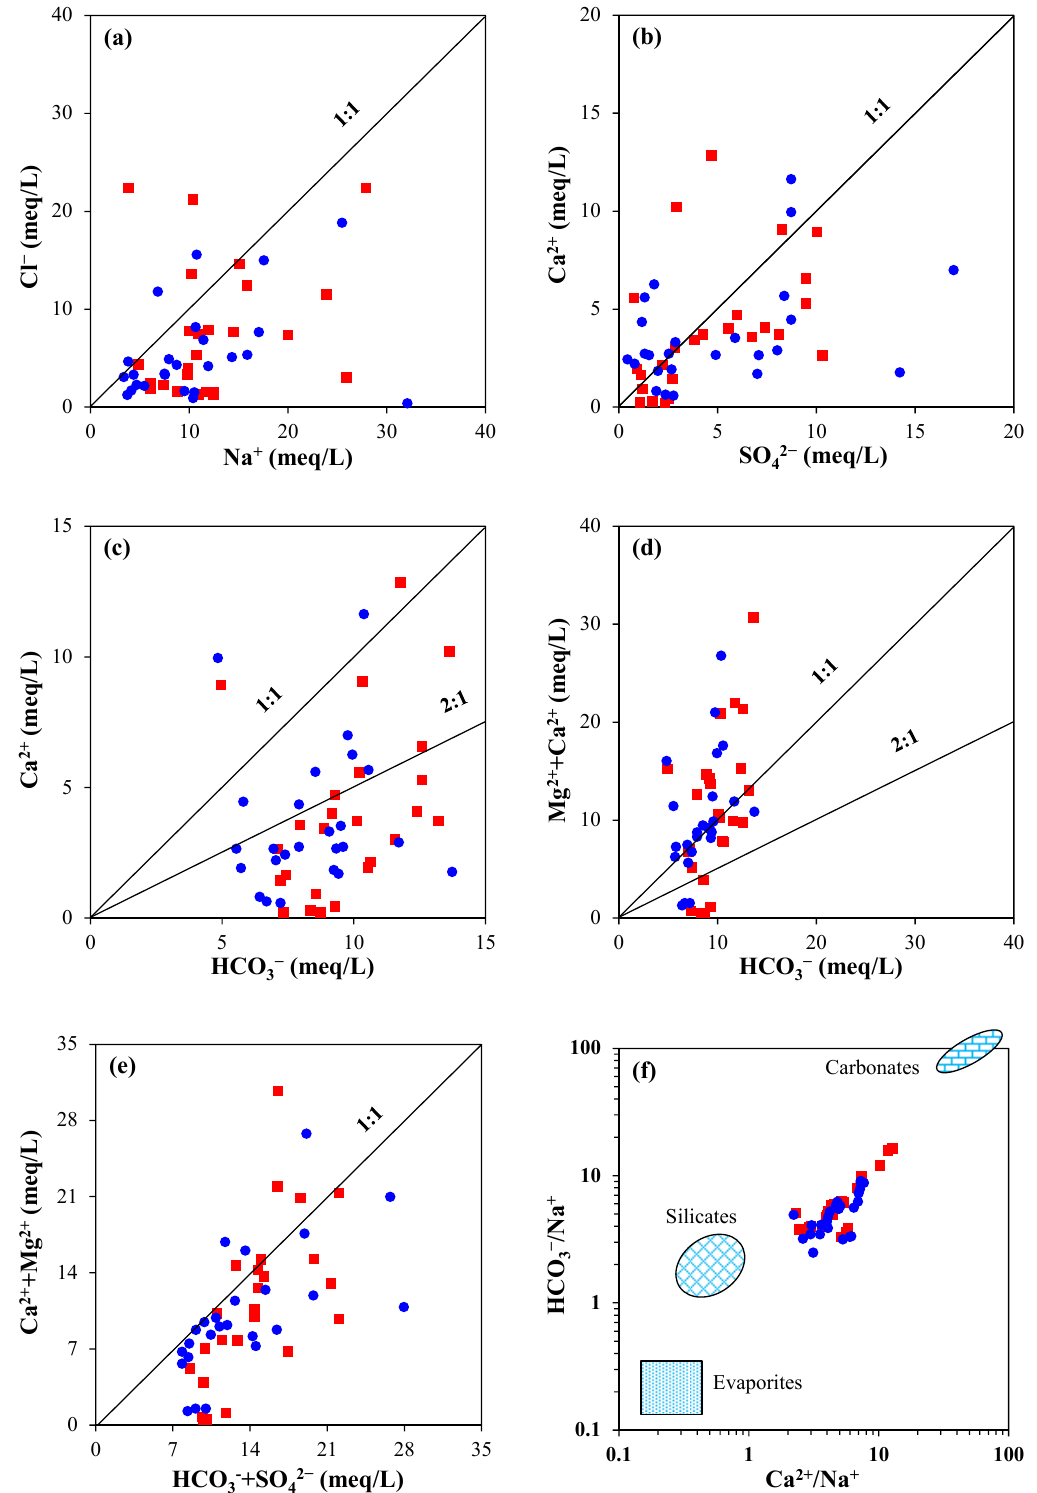
Figure 7. Plots showing ( a ) Na + versus Cl − , ( b ) SO 42 − versus Ca 2+ , ( c ) HCO 3 − versus Ca 2+ , ( d ) HCO 3 − versus Ca 2+ + Mg 2+ , ( e ) (SO 42 − + HCO 3- ) versus (Ca 2+ + Mg 2+ ), ( f ) (HCO 3 − / Na + ) versus (Ca 2+ / Na + ).